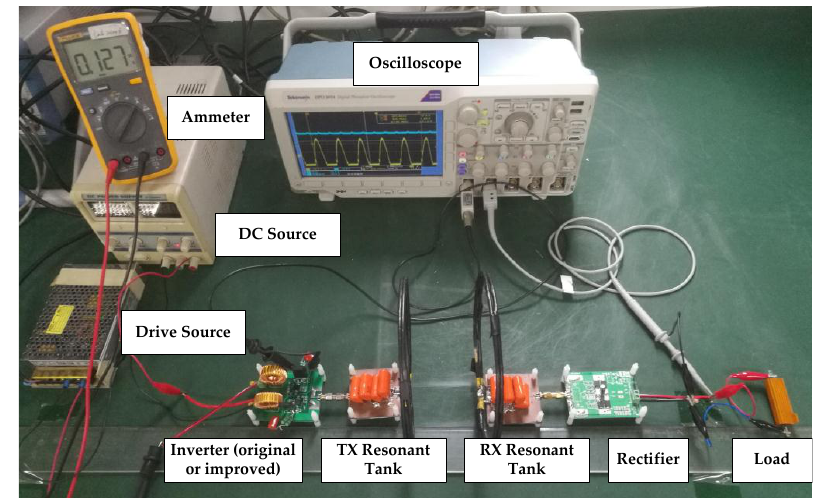
Figure 10. Photo of the experimental setup.